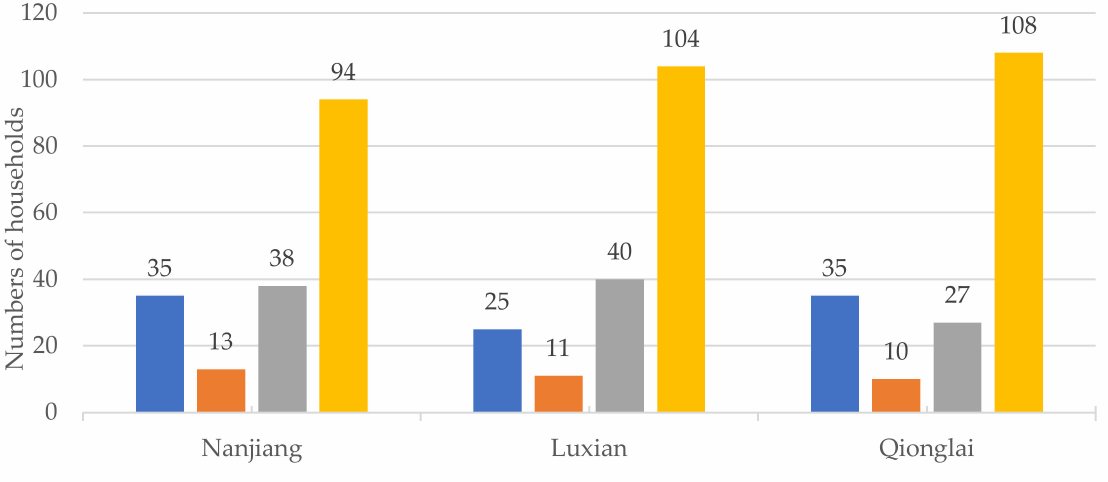
Figure 4. Distribution of household livelihood strategies in the study area.